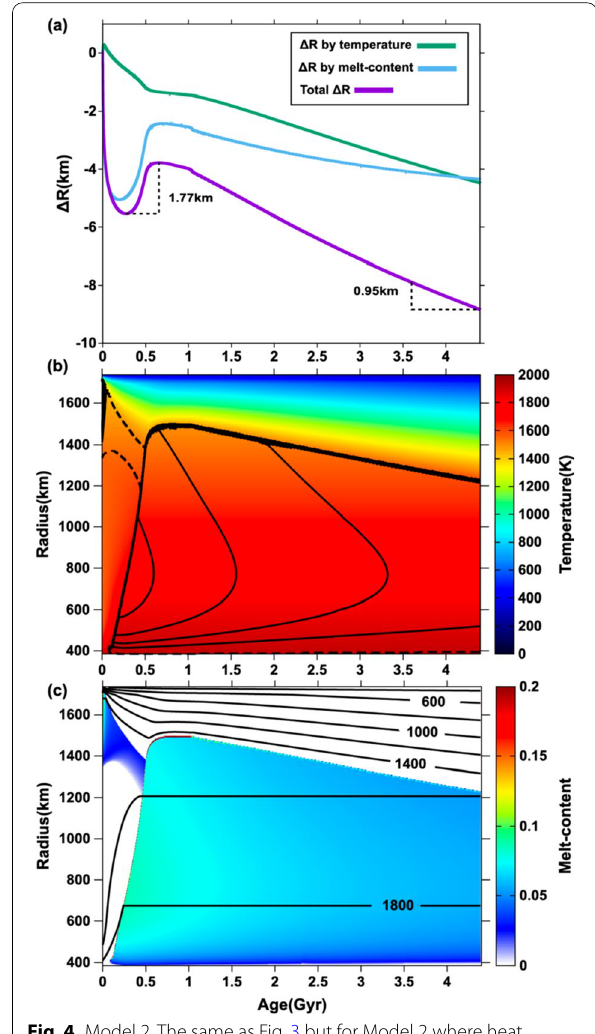
Fig. 4 Model 2. The same as Fig. 3 but for Model 2 where heat transport by migrating magma is added to Model 1 shown in Fig. 3; transport of heat, and the end-members A and B by migrating magma is not considered. In b the contour lines show the distribution of melt with the contour intervals of 0.01 starting from 0 (the dashed